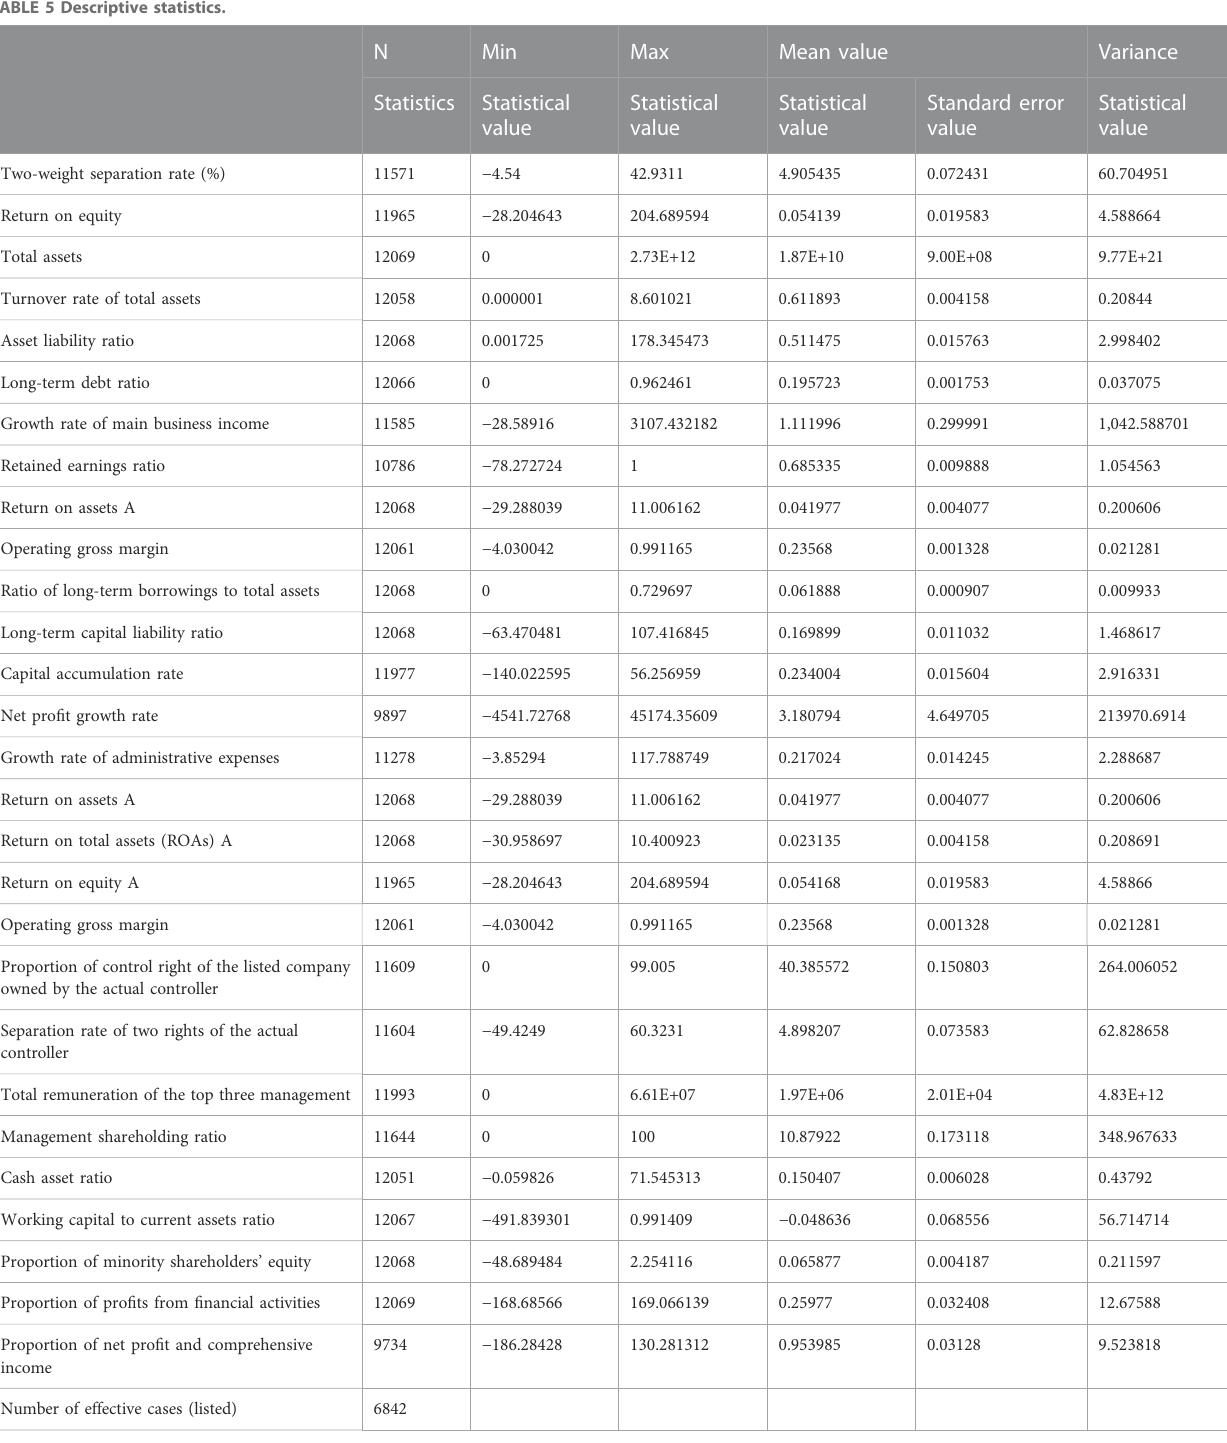
TABLE 5 Descriptive